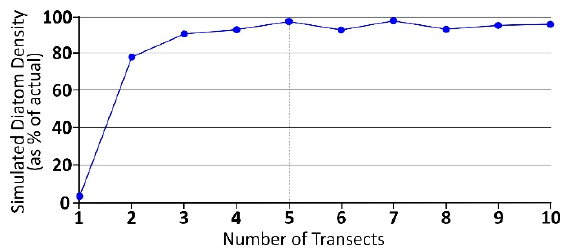
Figure 2. Mean diatom density produced by Monte Carlo simulations from counts of 1 to 10 transects.